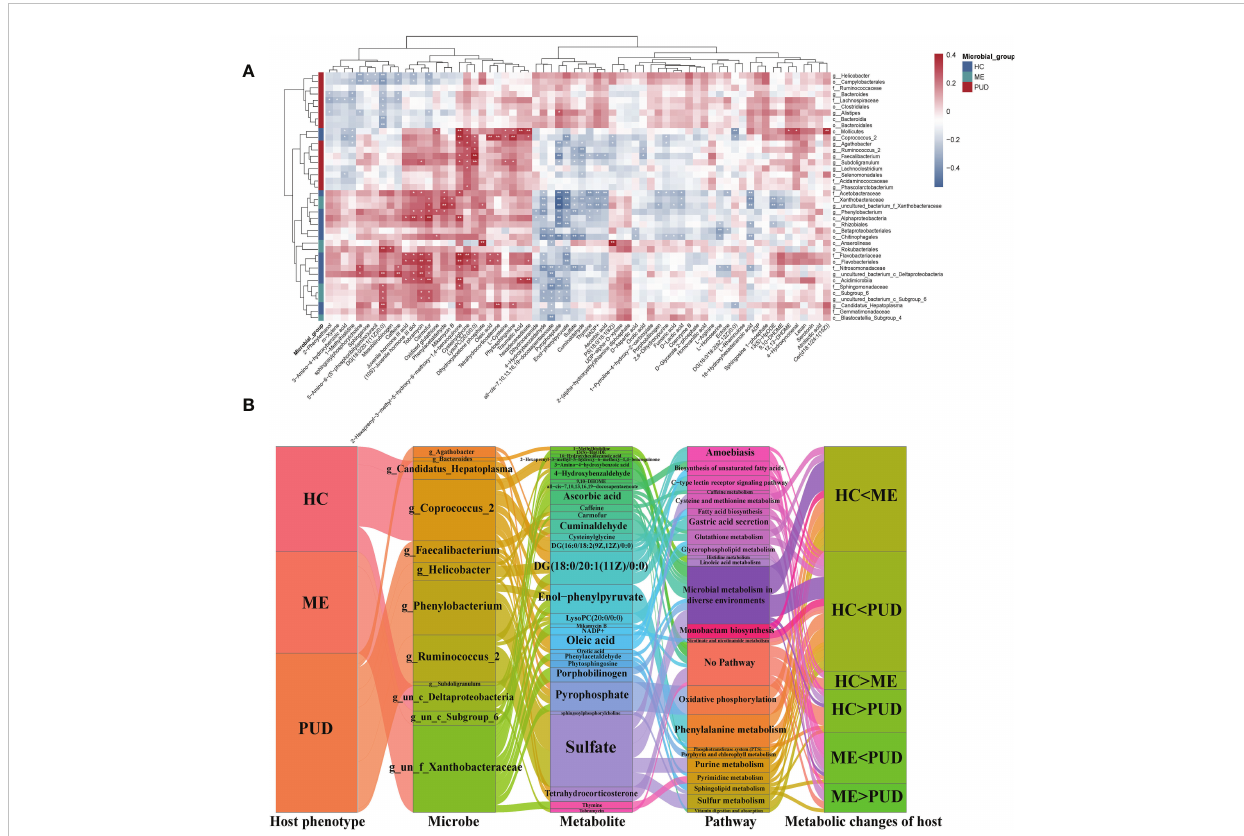
FIGURE 8 Intrinsic host phenotype-microbe-metabolite associations. (A) , Association of gastric fl ora and metabolites: heatmap of 66 identi fi ed metabolites and 46 differential fl ora correlation coef fi cients; Red-brown squares, positive correlations between these microbes and metabolites; blue-gray squares, negative correlations; the signi fi cance of statistics is indicated by “ * ” and “ ** ” (*P< 0.05, **P< 0.01). (B) , host population-metabolite-metabolic pathway-phenotype variations, and the Sankey diagram broadly depicted host phenotypic n differential fl ora n differential metabolites n metabolic pathways n host phenotypic variations; Microbe section, only the set of genera with metabolite correlations greater than 0.3; metabolite section, the set of metabolites with bacteriophage correlations greater than 0.3; Pathway section, only the host-microbe metabolic pathways and related disease pathways; g, genus; f, family; un, unidenti fi ed bacteria; “ < “ and “ > “ , metabolite content